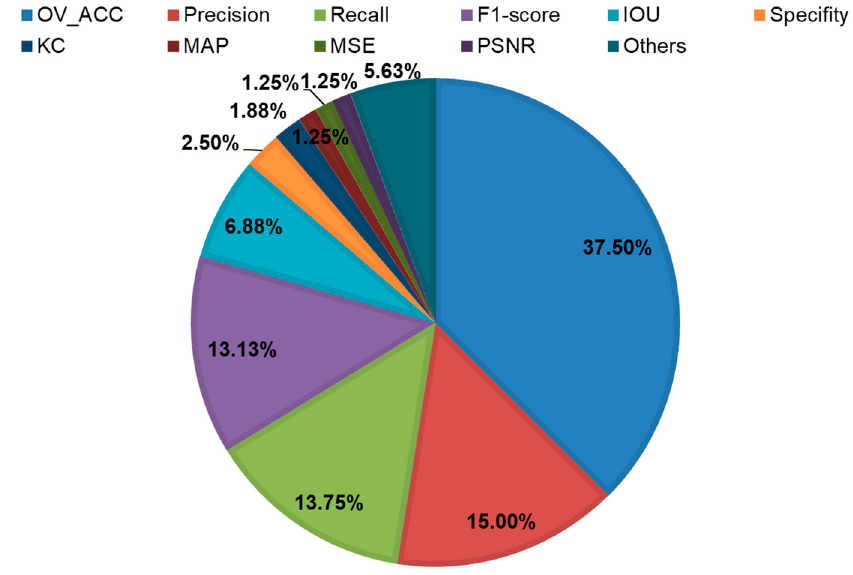
Figure 17. Distribution of performance metrics in the CBD_NDT domain.